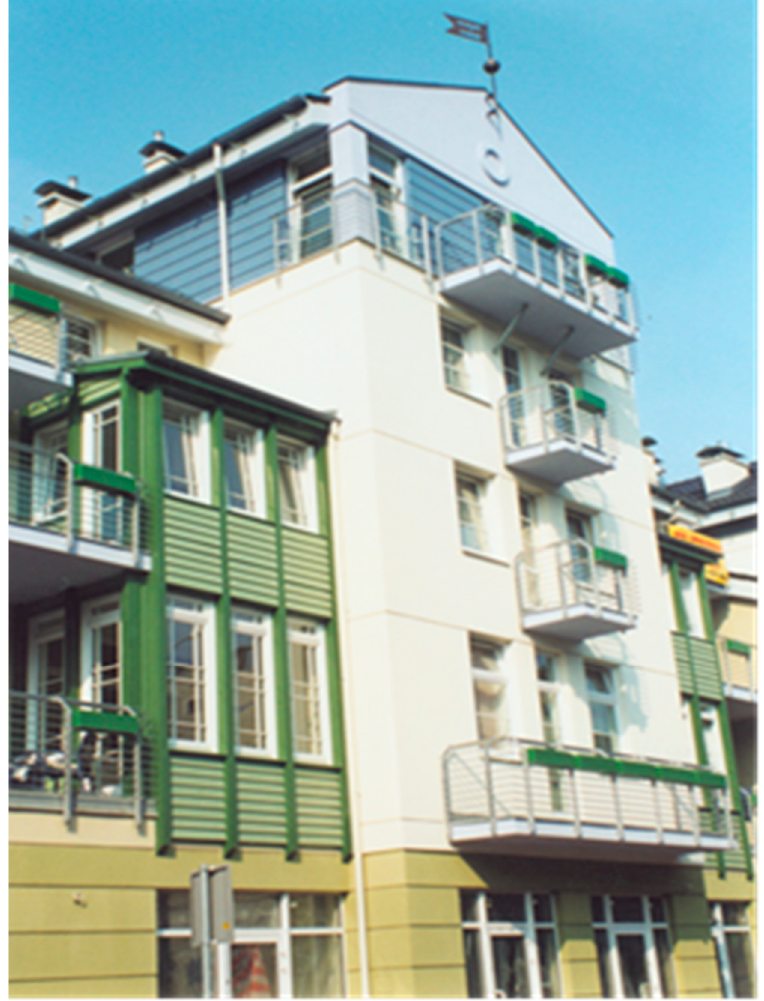
Figure 5. Residential building completed in 2002, Ogrodowa street in Sopot. Source: A. Taraszkie- wicz.